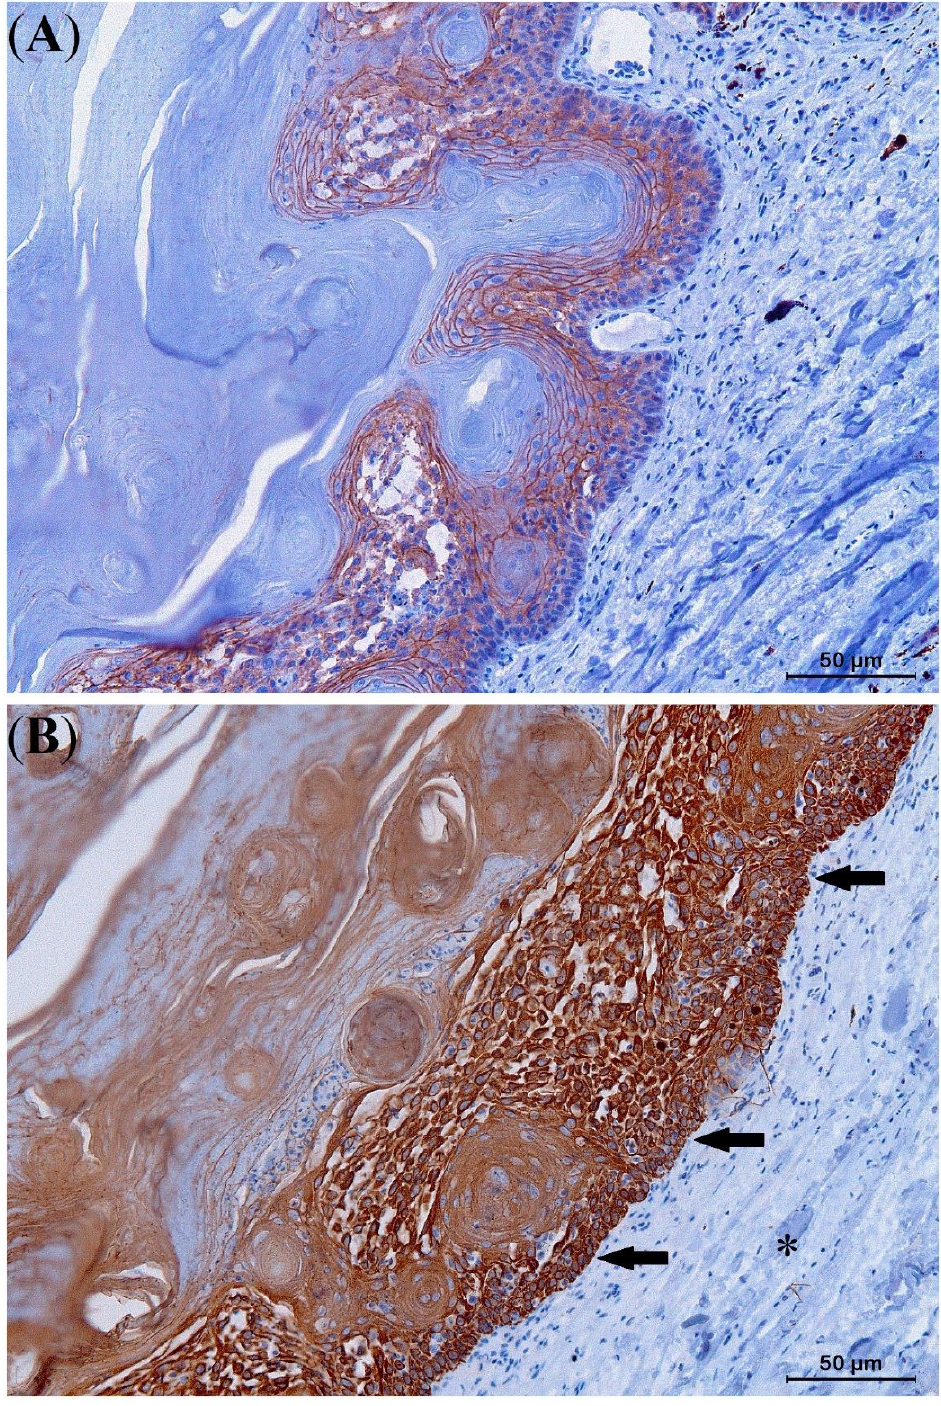
Figure 7. Immunohistochemical results of a keratoacanthoma (KA) from the lateral body wall of a panther chameleon ( Furcifer pardalis ) ( A , B ). Intense E-cadherin staining with immunoreactivity at the level of the plasma membrane of all neoplastic cells ( A ). Strongly positive pan-cytokeratin staining showing specific intracytoplasmic immunoreactivity abruptly delineating the neoplastic tissue (arrows) from the healthy skin (asterisk) ( B ).